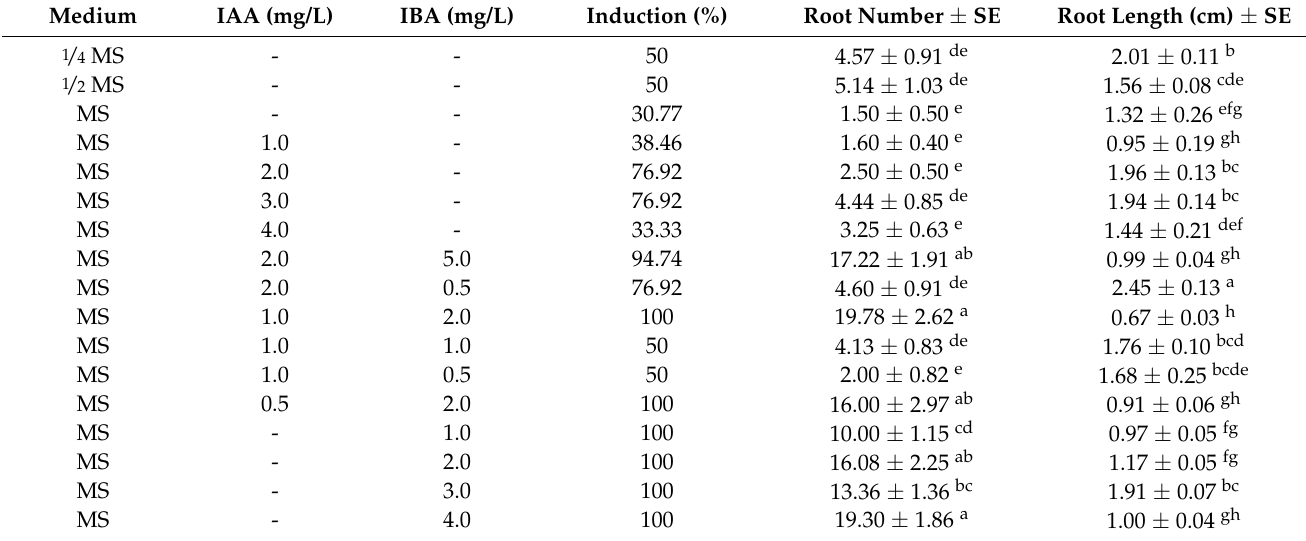
Table 5. The influence of auxins on Linnaea borealis var. borealis shoot rooting.